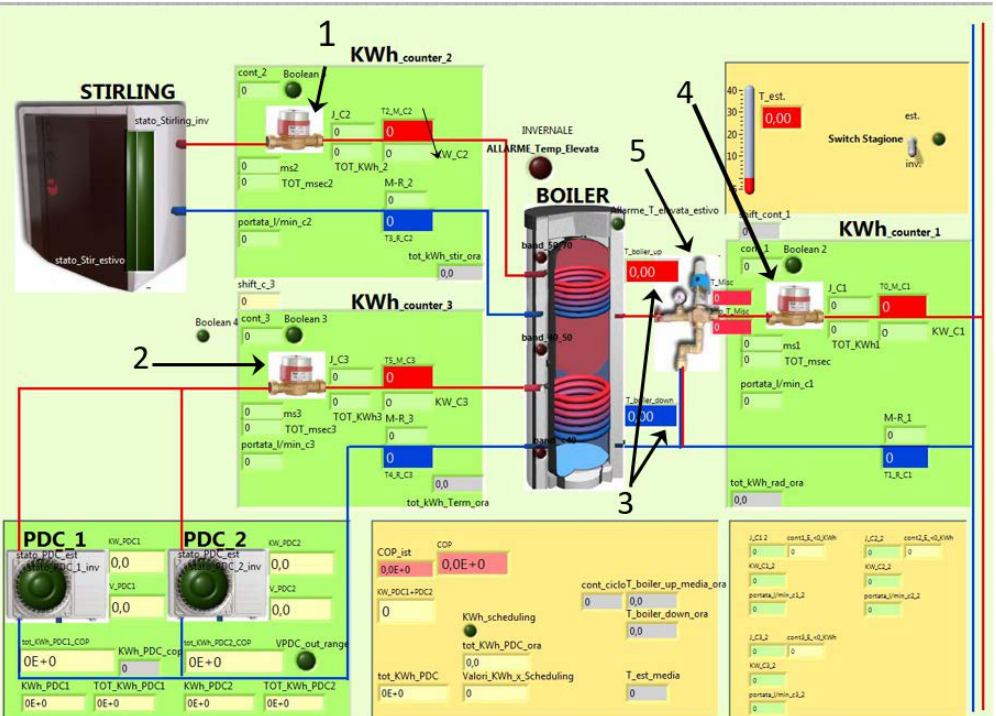
Figure 4. Front end developed for the air-conditioning control and for data acquisition with the position of the different probes used for the experimental activity: 1 = integration system heat counter, 2 = heat pumps heat counter, 3 = temperature sensors, 4 = emitters heat counter and 5 = mixing valve, PDC= heat pump. Table 2. Main features of the sensors employed in the monitored air-conditioning plant. Temperature Flow Rate AC Electric Power